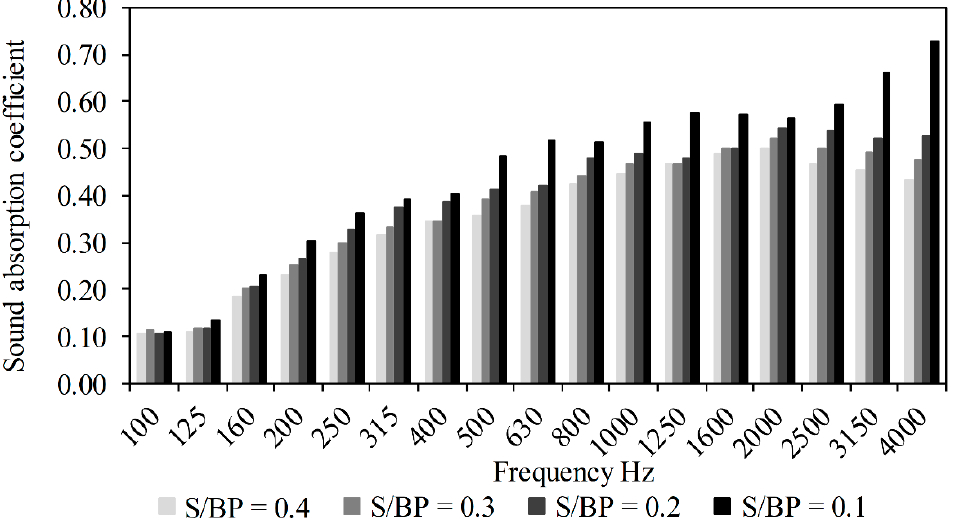
Figure 12. Sound absorption coefficient as a function of frequency.